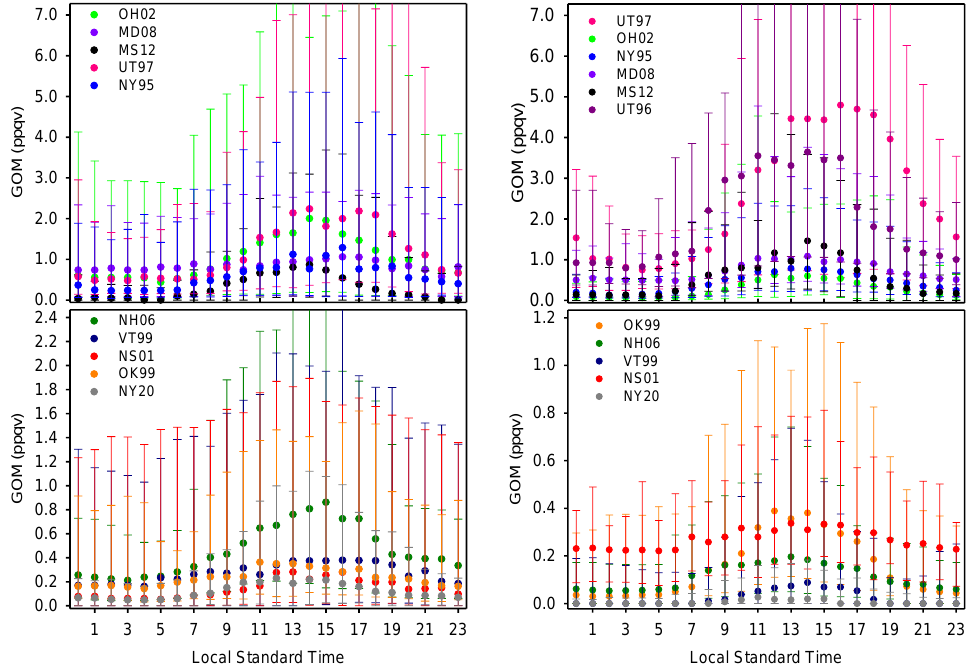
Fig. 7. GOM diurnal variation in 2009 spring (left panel) and 2009 summer (right panel). The upper error bars represent 90 percentile while the lower error bars represent 10 percentile values.